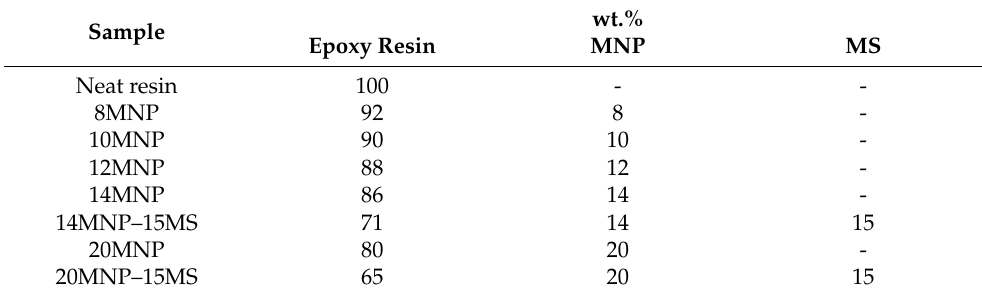
Table 1. Nomenclature and compositions (wt.%) of bulk samples